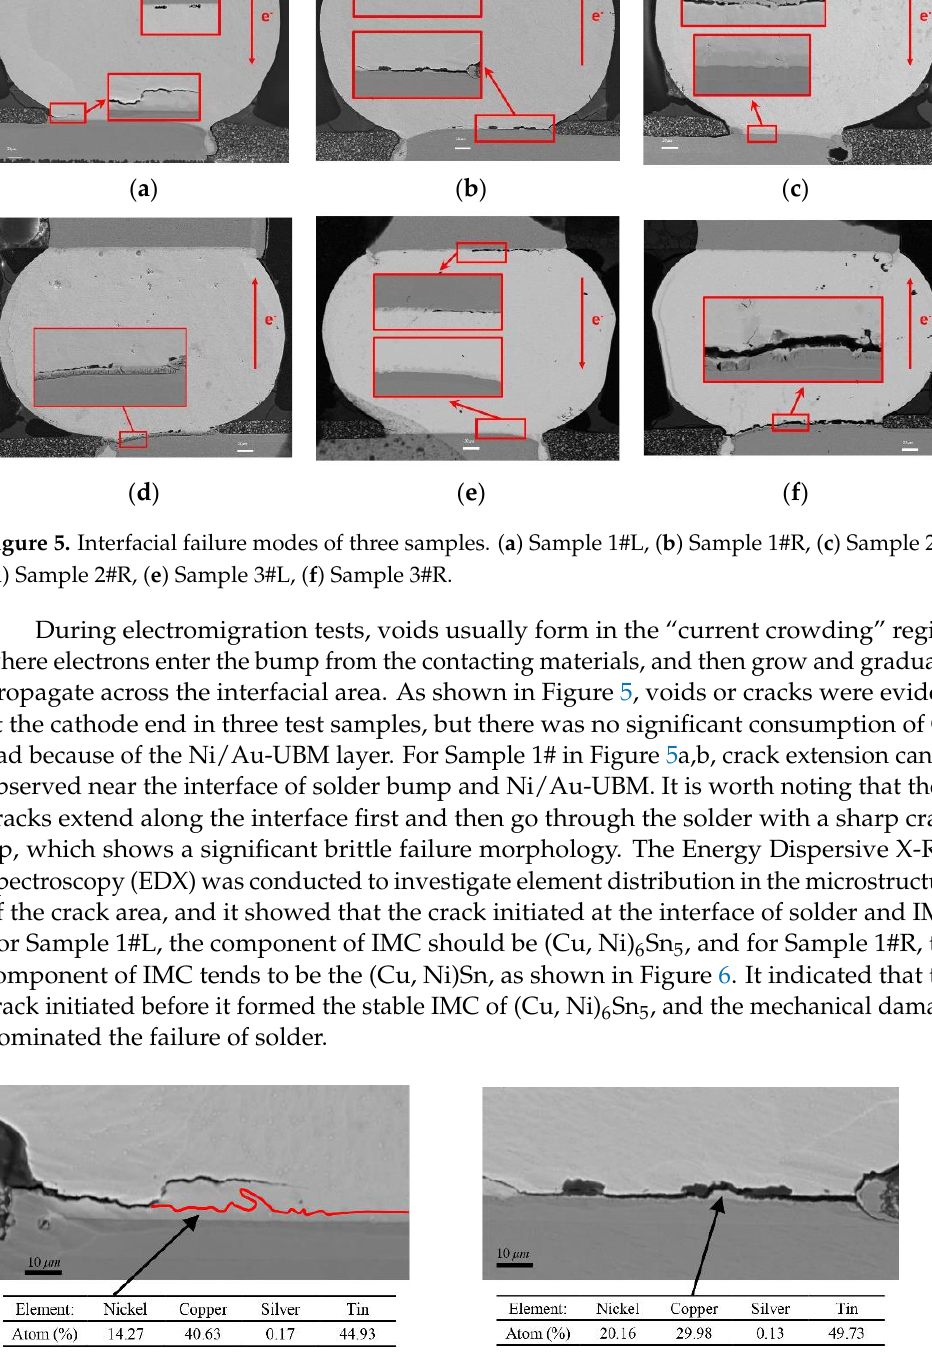
Figure 6. EDX results at the crack area of ( a ) Sample 1#L and ( b ) Sample 1#R.